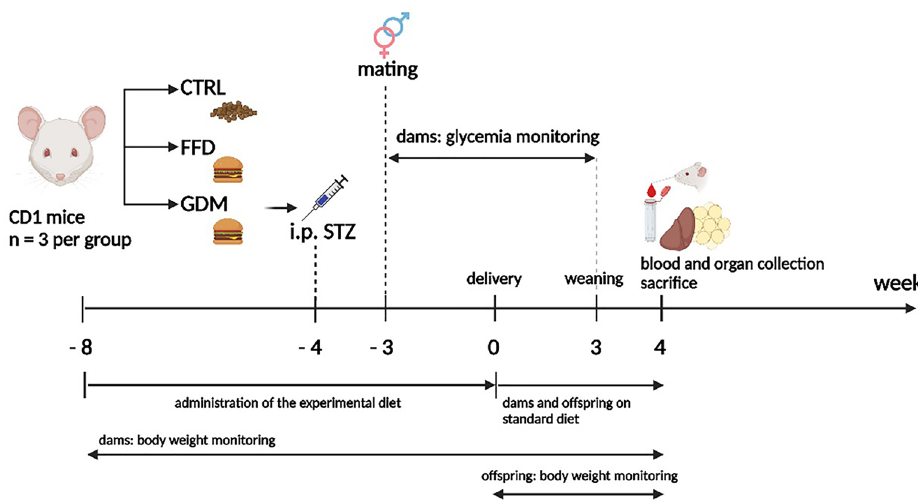
Figure 7. Flowchart of the experiment CTRL, dams on control diet; FFD dams consuming a fast-food diet, GDM dams on a fast-food diet with gestational diabetes mellitus, STZ streptozotocin; Created with https:// BioRe nder.